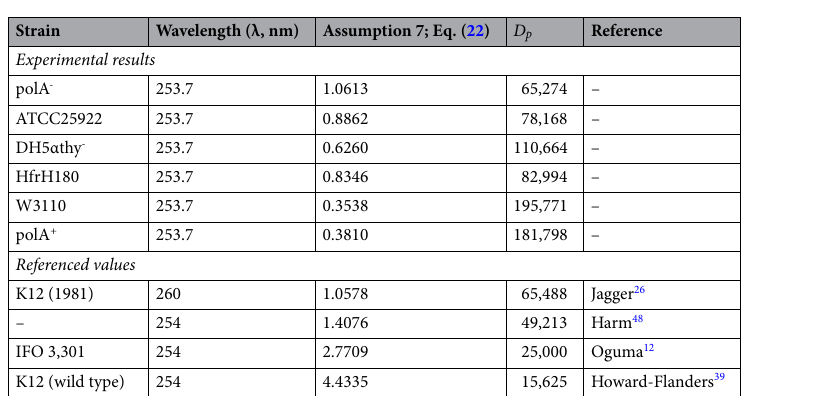
Table 4. Assumption (7) for Eq. (22) in experimental and other E. coli strains.